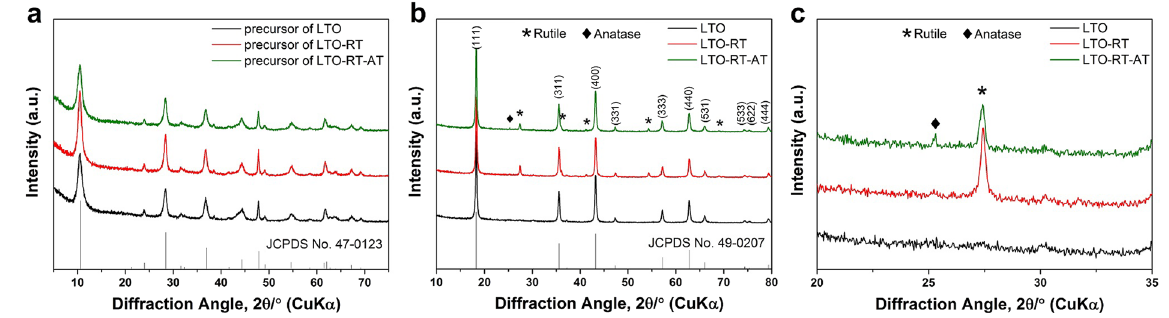
Figure 1. ( a ) XRD patterns of the precursors of pure LTO, LTO-RT and LTO-RT-AT, ( b ) XRD patterns of the three samples after calcination at 600 °C for 6 h in air, ( c ) partially enlarged XRD patterns from 20° to 35° in ( b